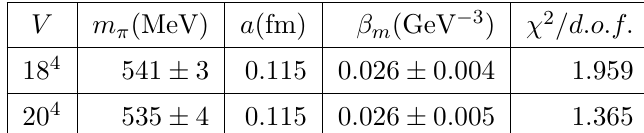
Figure 12. The energy squared of the ground state of (cid:26) (cid:0) ( (cid:26) + ) meson with s z = +1 ( s z = (cid:0) 1) depending on the magnetic (cid:12)eld value for lattice volumes 16 4 , 18 4 , 20 4 , lattice spacings 0 : 095 fm, 0 : 115 fm and various pion masses with the (cid:12)ts made using formula (4.2). V m (MeV) (cid:25)